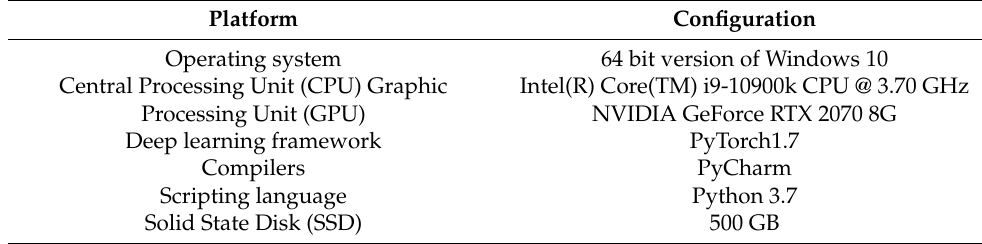
Table 1. Configuration of the experimental